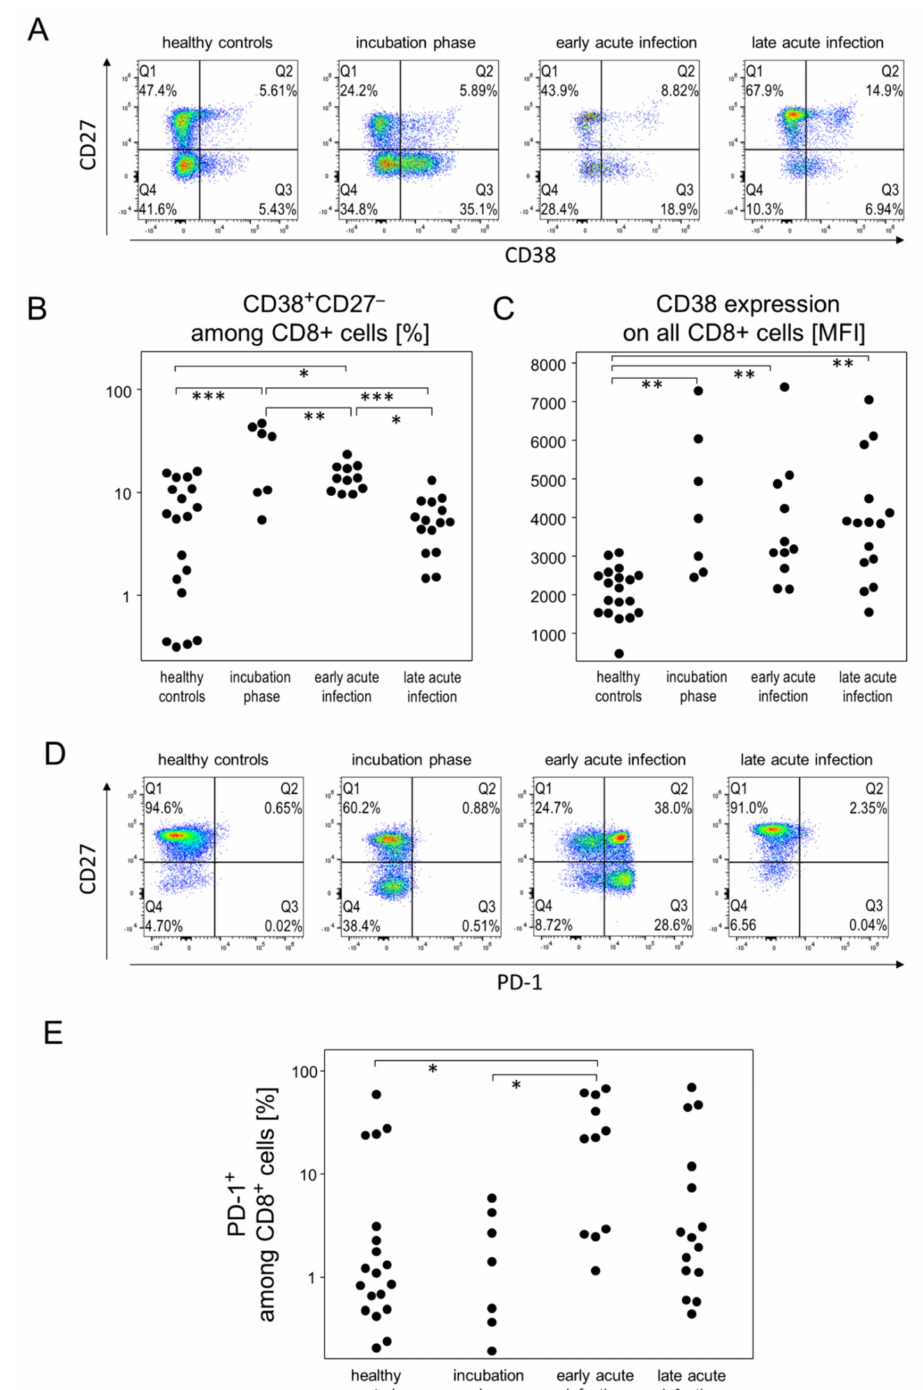
Figure 5. The scope of cytotoxic T lymphocytes activation depended on the respective disease stage during mild-to-moderate COVID-19. ( A ) Representative pseudocolor plots of CD38 and CD27 expression data of CD8 + T cells demonstrated the accumulation of the CD38 + CD27 − subpopulation (Q3 gate) during the incubation and early acute infection phases. ( B ) Quantitative flow cytometry data of CD8 + CD38 + CD27 − T cell proportions. ( C ) CD38 expression by CD8 + T cells at the different disease stages. ( D ) Representative plots of PD-1 and CD27 expression data showed an increase of PD-1 + T cells that are either CD27 + (Q2 gate) or CD27 − (Q3 gate). ( E ) Quantitative data of CD8 + PD- 1 + T cell proportions showed their enrichment during the incubation and acute infection phases. * p < 0.05; ** p < 0.01; *** p < 0.001; Tukey-Kramer